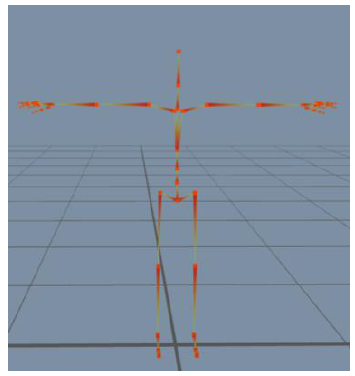
Figure 13. Skeleton from iPi MoCap Studio